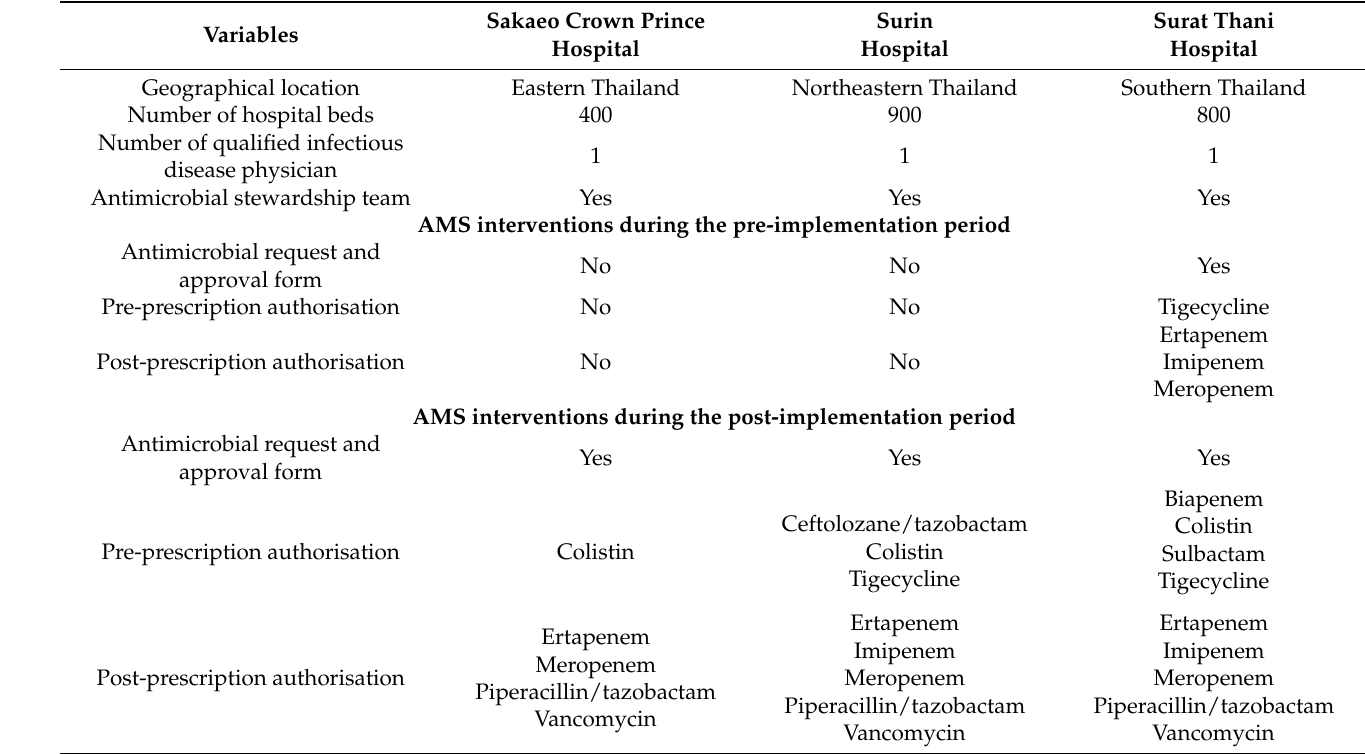
Table 6. Hospital infrastructure, existing antimicrobial stewardship activities, and targeted antimicro- bial agents at three participating